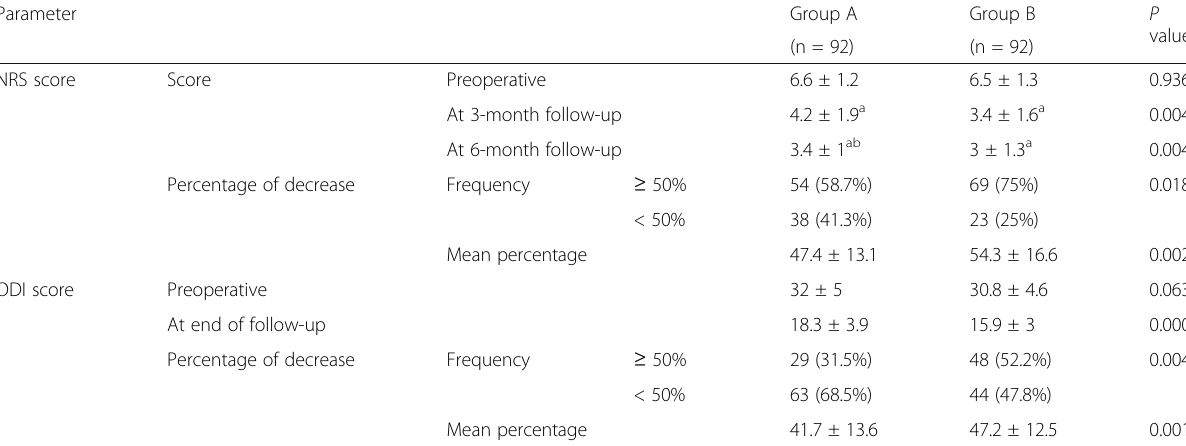
Table 5 Pain NRS and ODI scoring of studied patients at 3- and 6-month PO